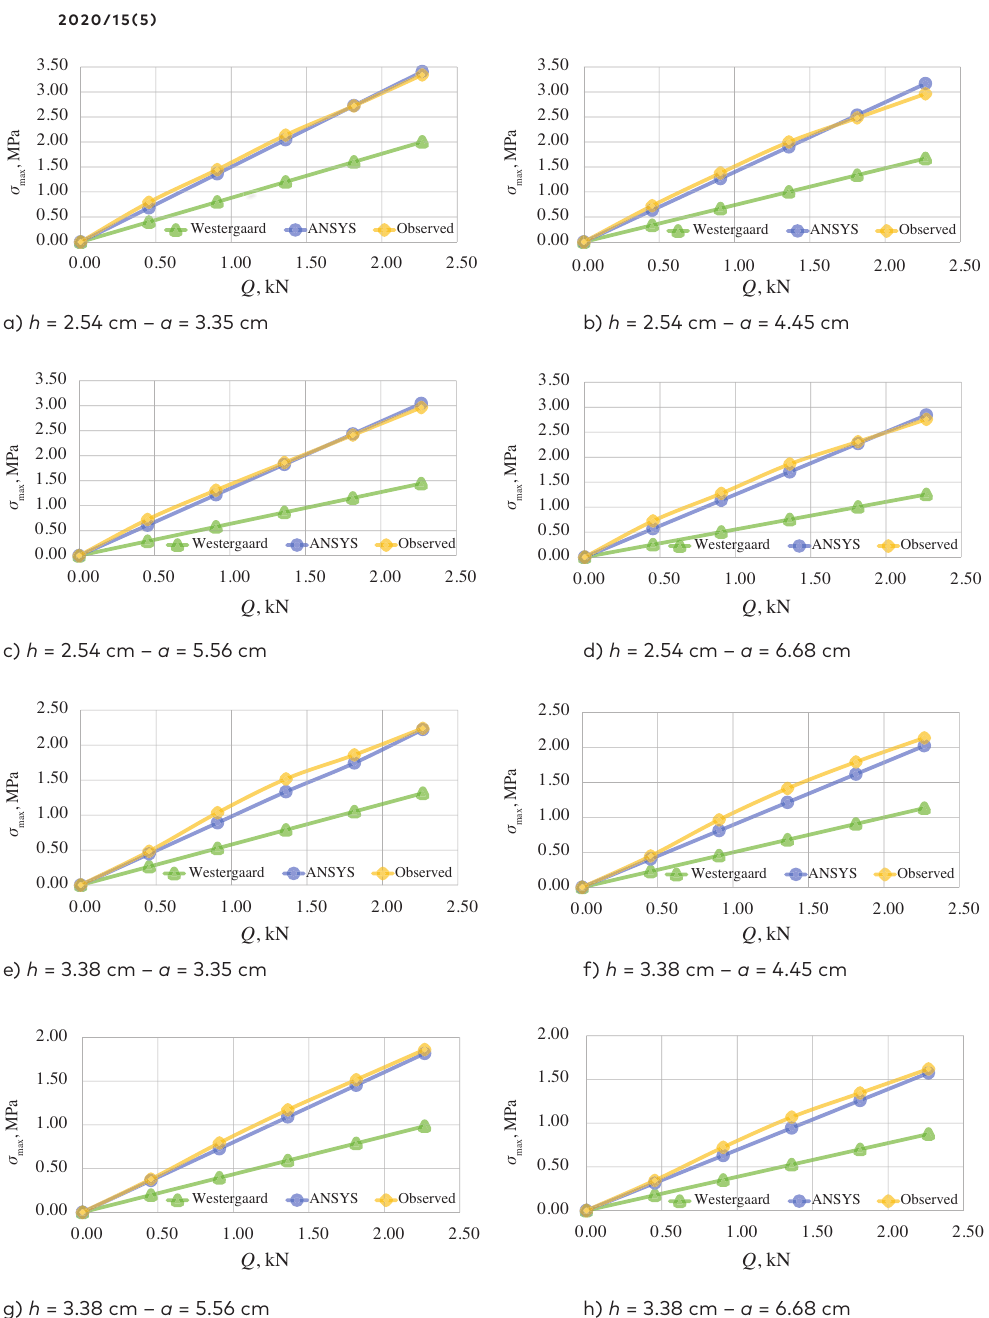
Figure 13. Load-stress relations with load at the